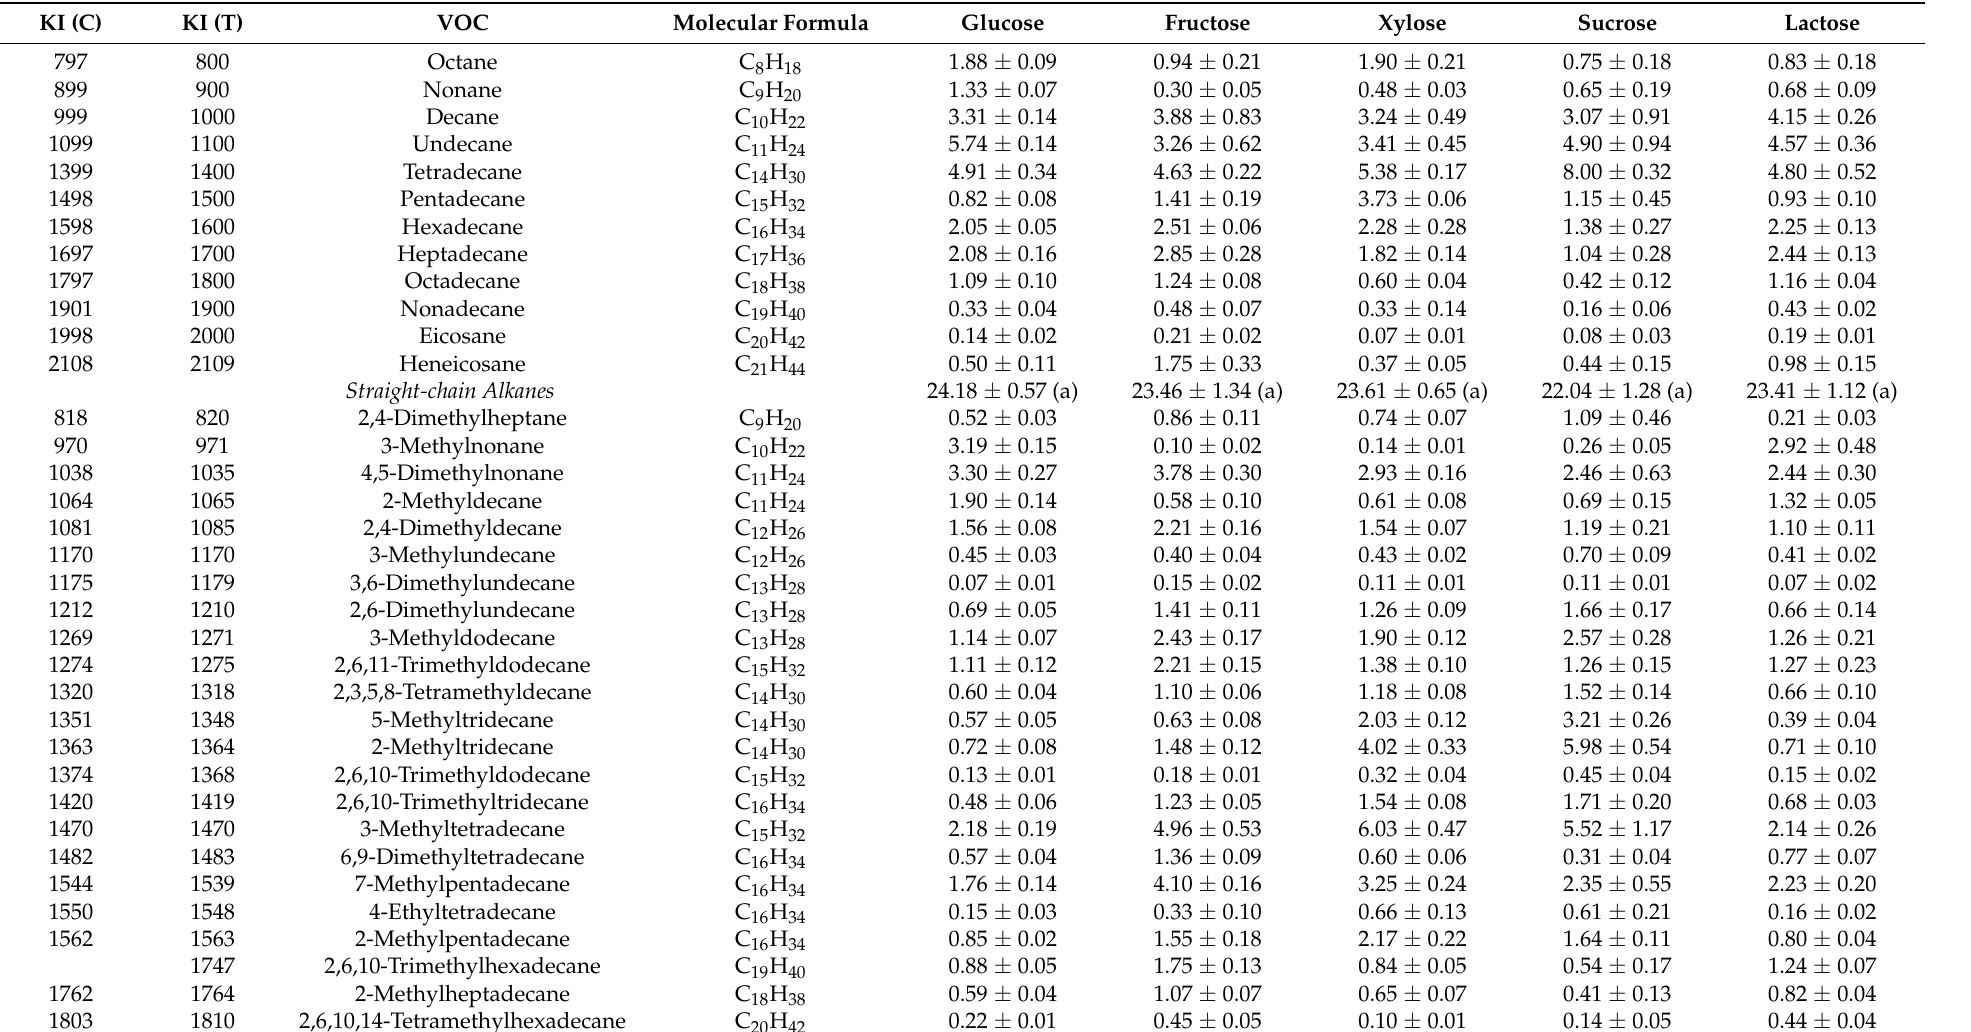
Table 1. Detected VOCs from F. verticillioides 7600 grown in GYAM culture medium supplemented with different carbon